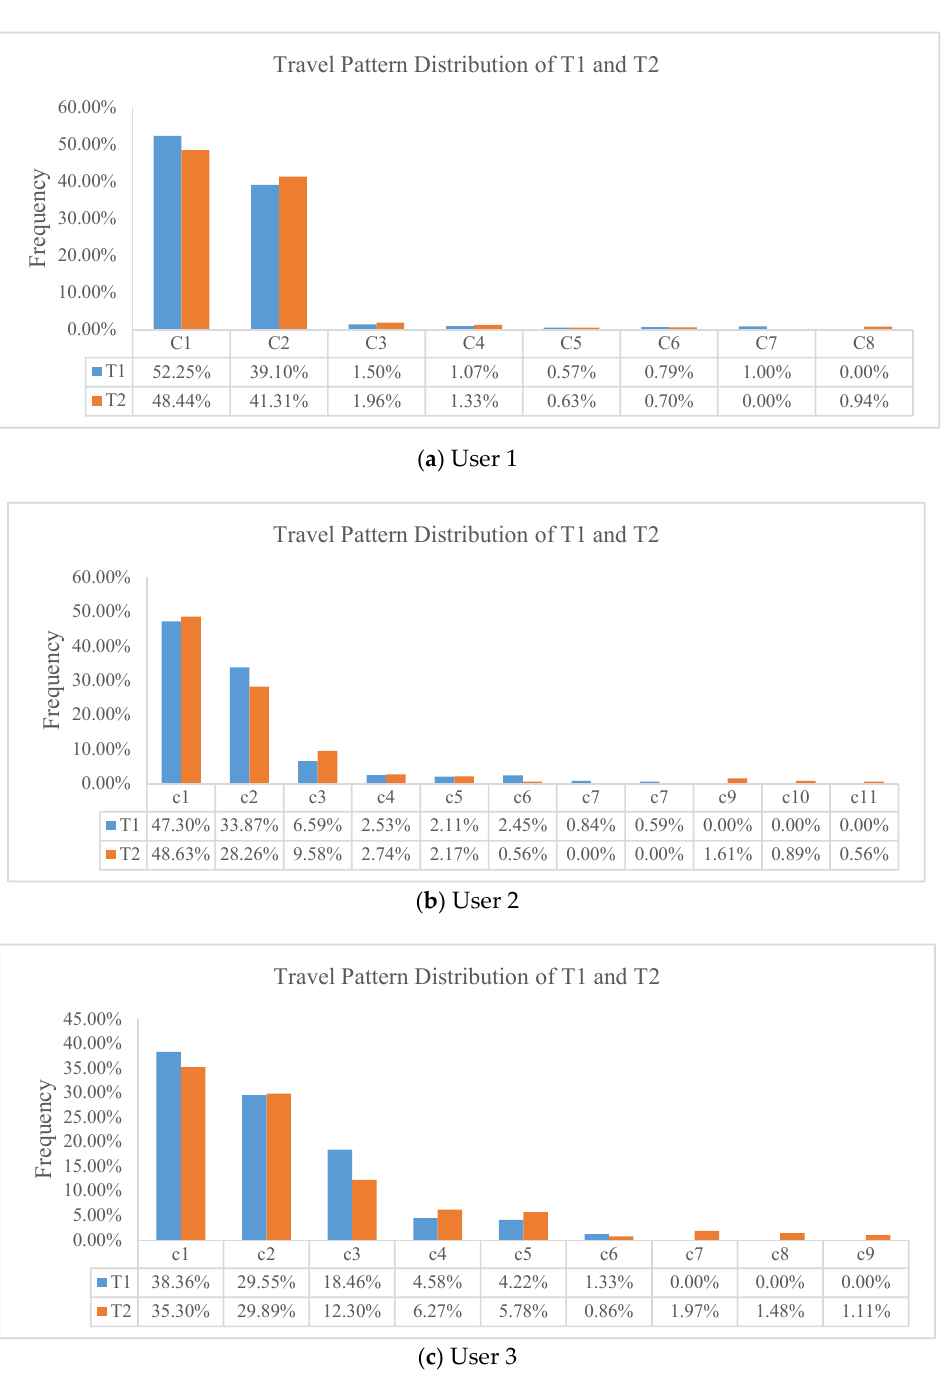
Figure 7. The distribution of travel patterns at T1 and T2 for the three users. Table 2. Change detection results for User